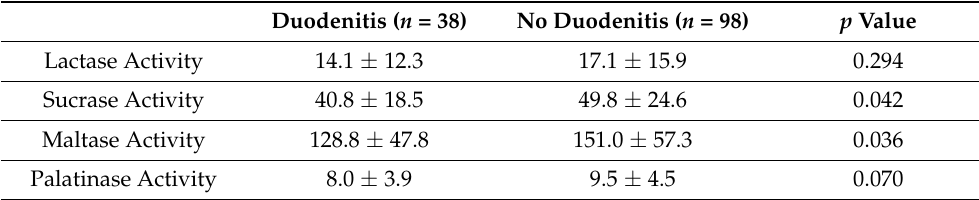
Data are indicated as mean +/ − SD; p values were calculated using the student’s t test.